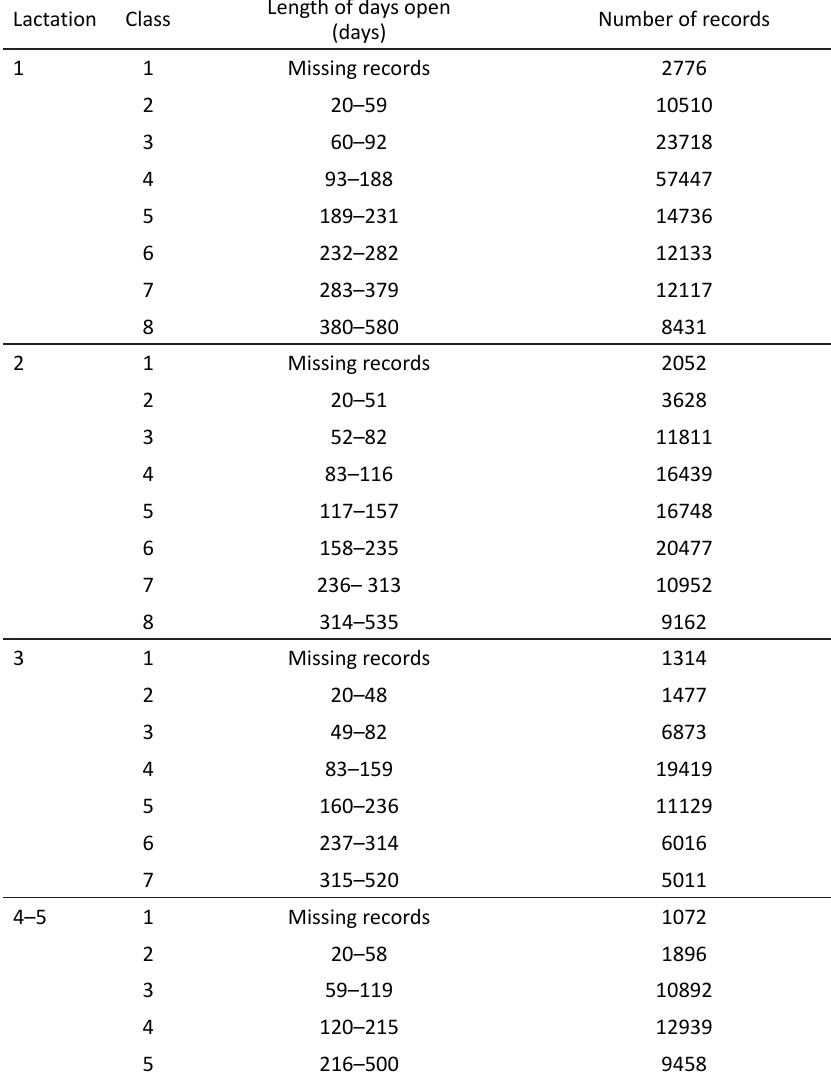
Table 3. Number of records in various days open classes and lactations